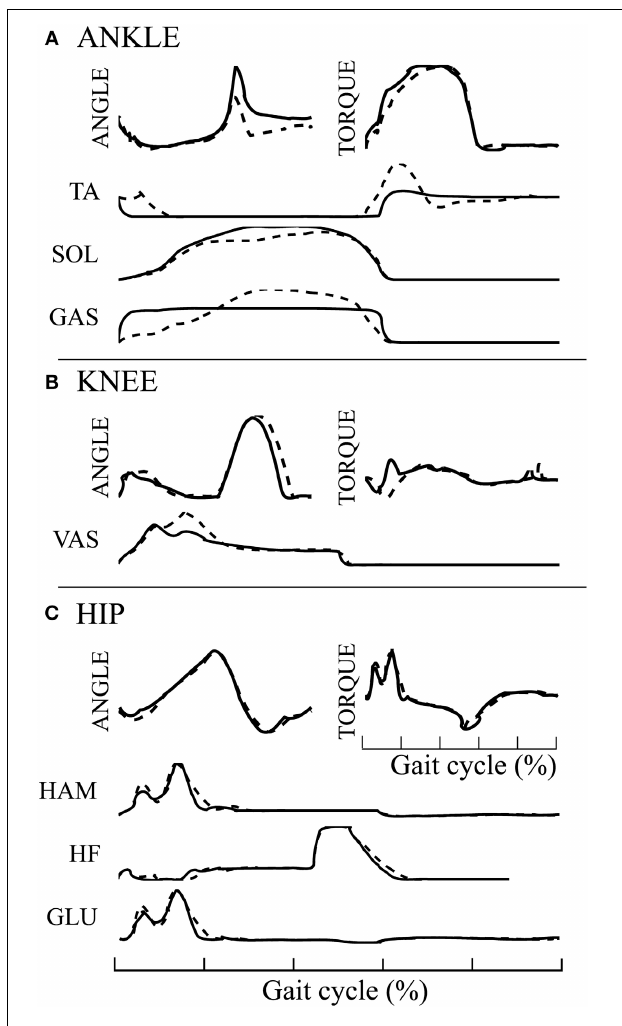
FIGURE 7 | Comparison of average joint angles, joint torques and muscles activation pattern between the 3FBL min FBL models (dashed line) for solution 1. (A) ANKLE angle, torque and associated muscles activation level, (B) KNEE angle, torque and associated muscles activation level, and (C) HIP angle, torque and associated muscles activation